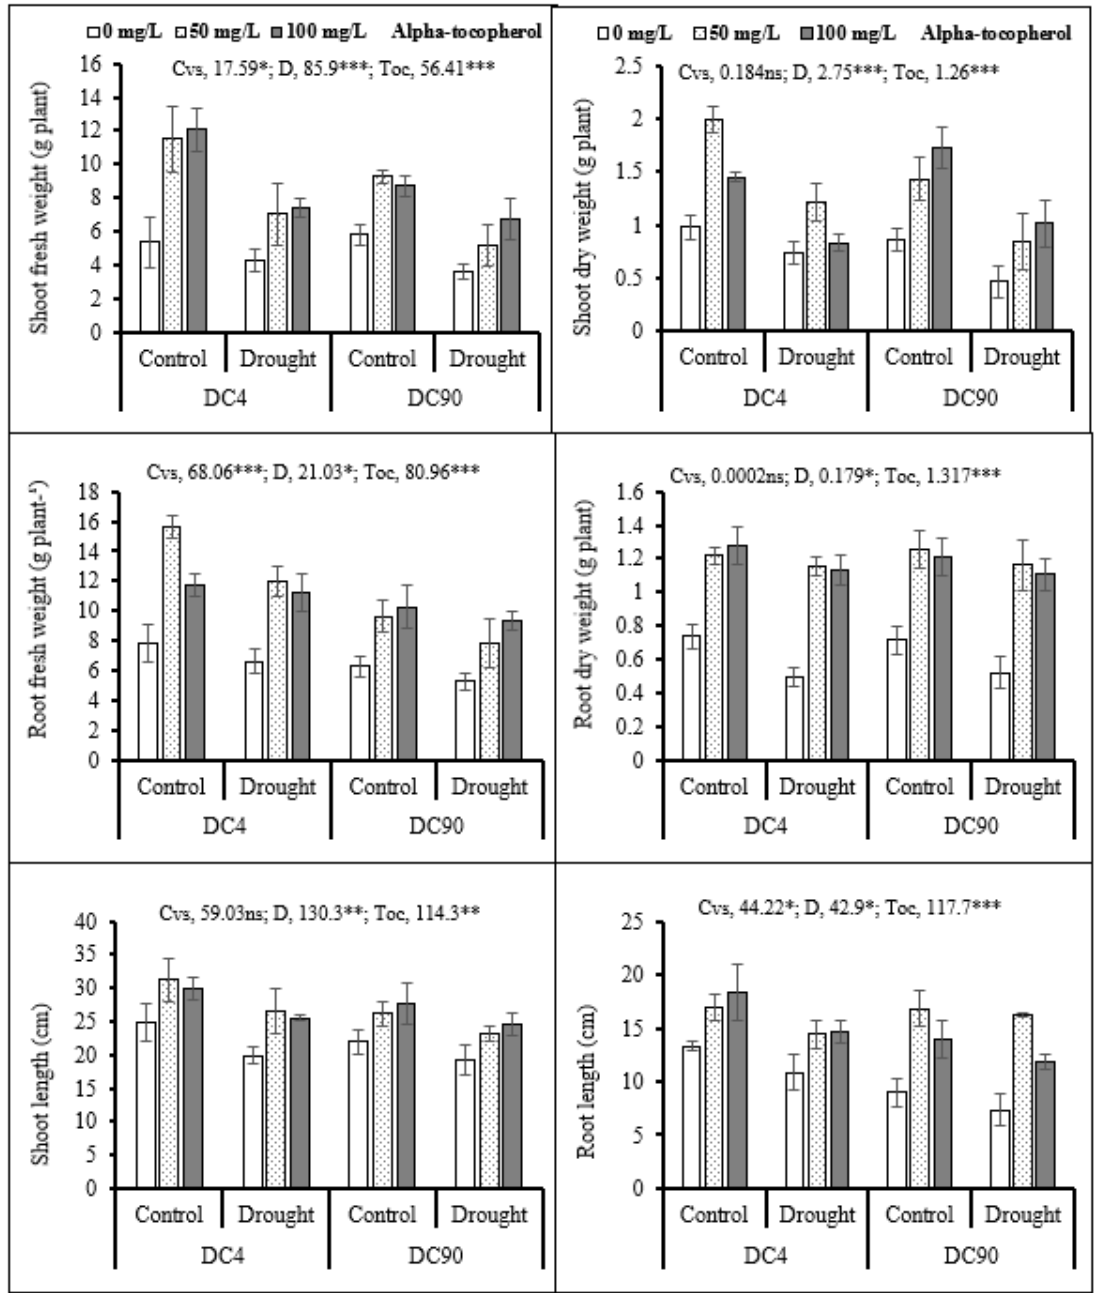
Figure 1. Effect of different levels of alpha-tocopherol on shoot fresh weight, shoot dry weight, root fresh weight, root dry weight, shoot length and root length of 51-day-old carrot cultivar grown under control (normal watering) and drought (50% field capacity) stressed environments. Bars sharing different letter(s) for each parameter are significantly different from each other according to Duncan’s multiple range test ( p < 0.05). All the data represented are the average of three replications ( n = 3). Error bars represent standard deviation (SD) of three replicates. ns, non-significant, *, ** and ***; significant at 0.05, 0.01 and 0.001 levels.